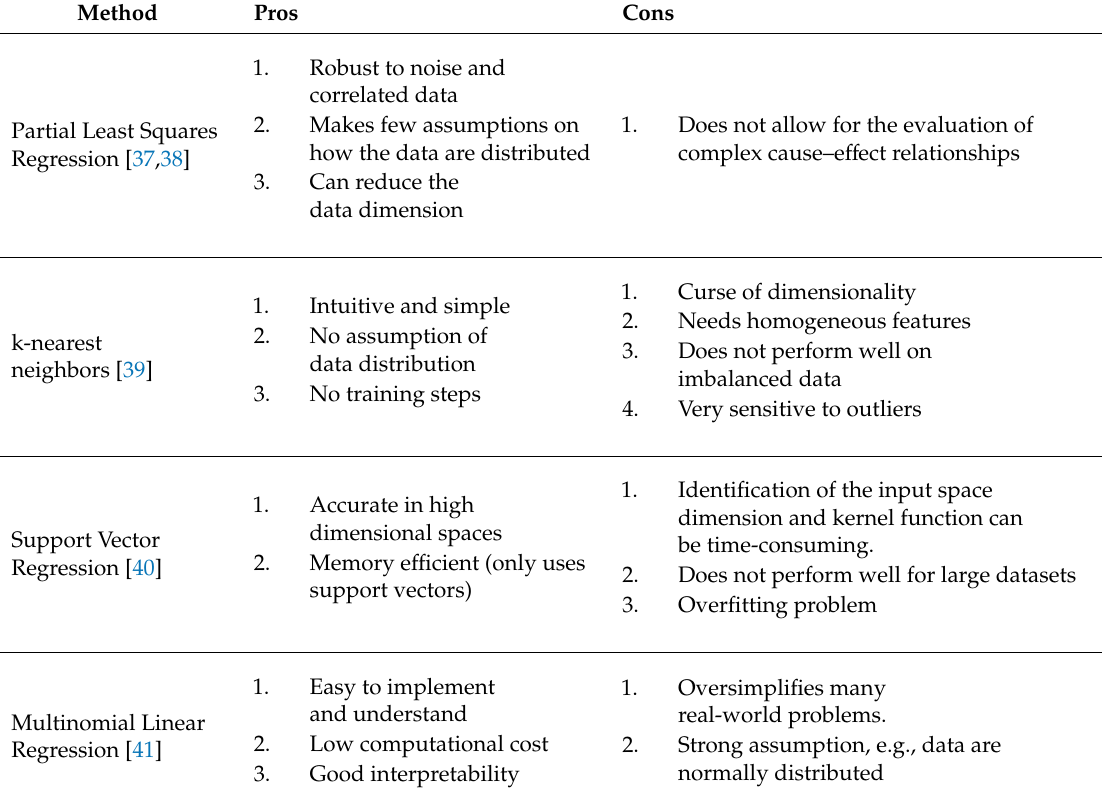
Table 4. Pros and cons of state-of-the-art